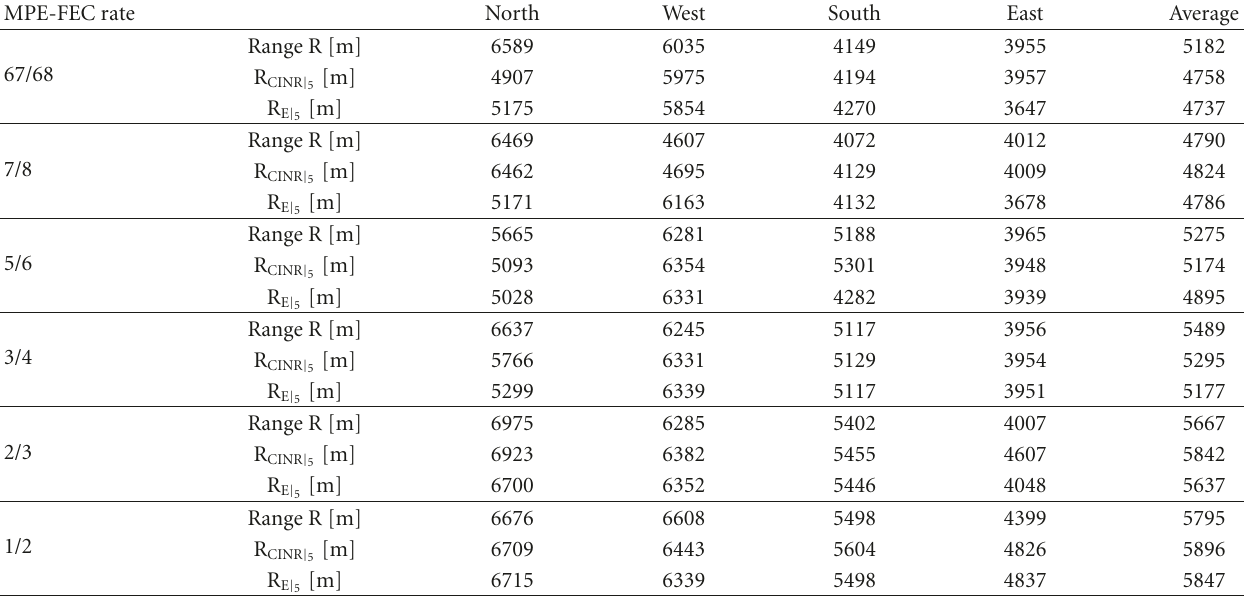
, and R E | for the di ff erent MPE-FEC rates and for the di ff erent directions. 5 5